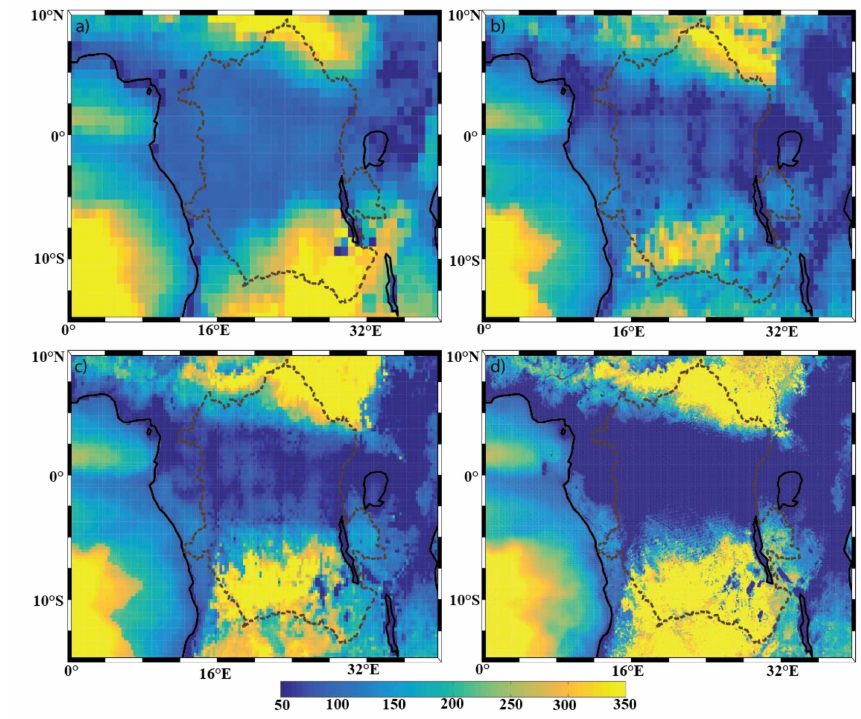
Figure 8. Spatial distribution of the evaporation decorrelation length scale (km) of the ( a ) ERA-I; ( b ) eERA5; ( c ) ERA5; and ( d ) ECOA datasets from 2016–2017. The Congo Basin is outlined with a dotted